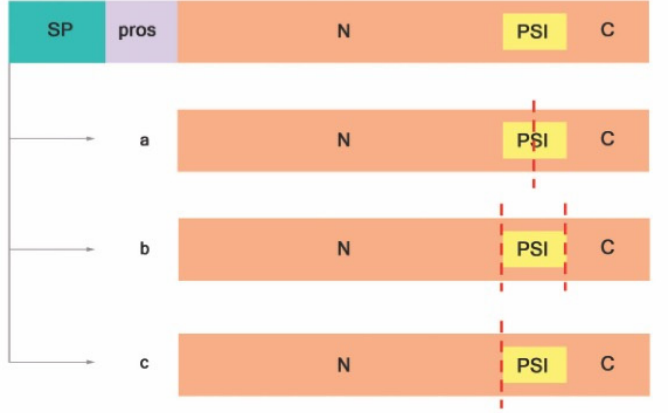
Figure 2. Proteolytic activation of typical APs adapted from Reference [41]. ( a ) PSI is digested at the midsection, ( b ) PSI is entirely removed, and ( c ) PSI and C-terminal are removed. Signal peptide (SP); prosegment (pros); plant-specific insert (PSI); N-terminal domain (N); C-terminal domain (C); red dashed lines indicate cleavage sites.